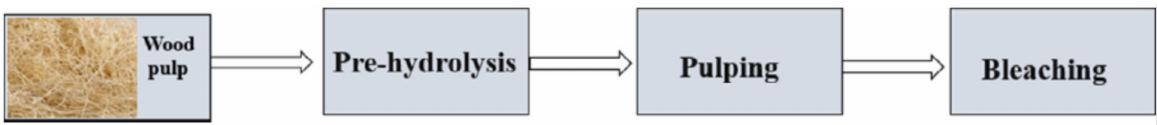
Figure 3. Extraction route for cellulose extraction from sources [69]. Copyrights: Elsevier,